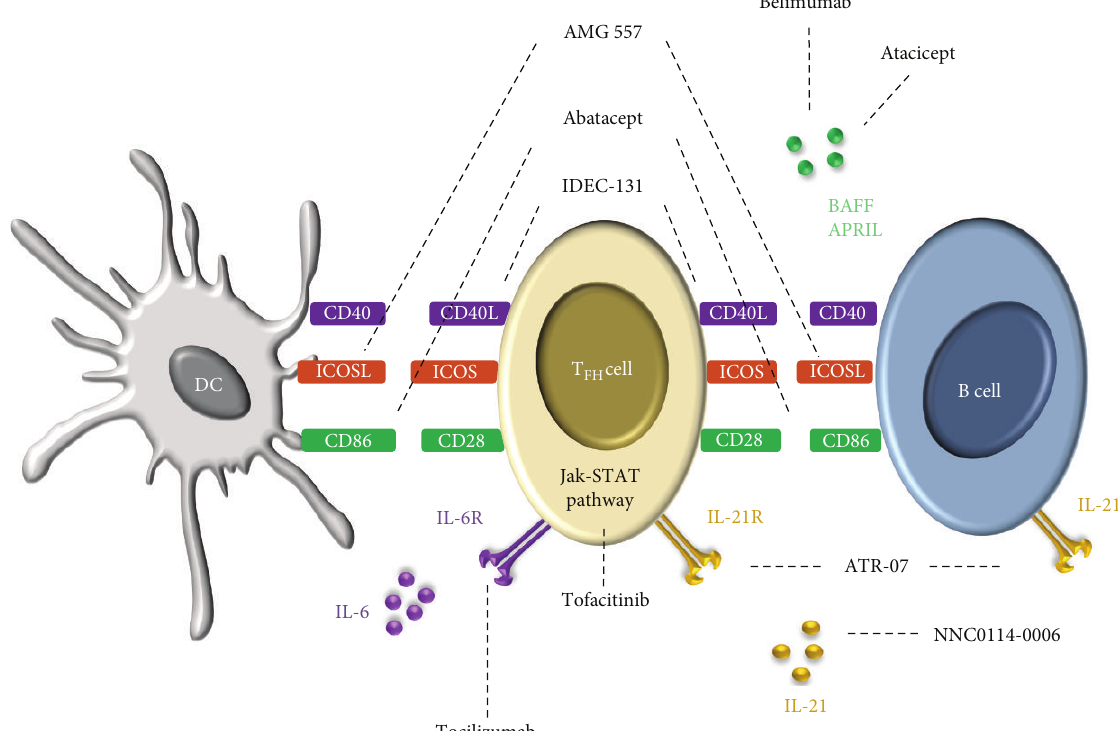
Figure 2: Therapeutic T -related targets in SLE: present and future. T function and differentiation can be affected by several biological FH FH drugs already used in SLE therapies or currently in clinical trials. Belimumab, Atacicept, and NNC0114-0006 are mAbs targeting the soluble molecules BAFF, APRIL, and IL-21, respectively. Moreover, the blocking of T cell costimulatory molecules with AMG-557 (ICOSL), Abatacept differentiation by decreasing the strength of T-B interactions. Finally, promising (CD28), and IDEC-131 (CD40L) could modulate T FH differentiation by blocking their signaling pathways either directly with the Jak-STAT inhibitor therapies could consist in inhibiting T FH Tofacitinib or indirectly by the blockade of cytokine receptors such as IL-6R (Tocilizumab) or IL-21R